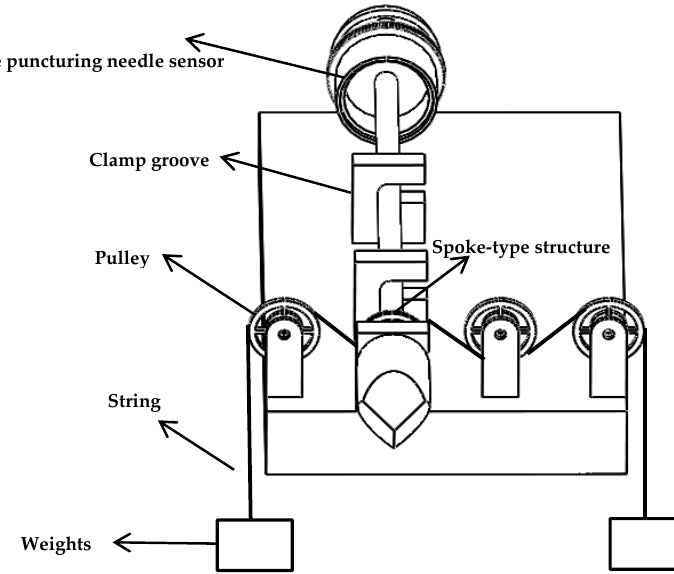
Figure 10. Structure diagram of the torque force experimental device.